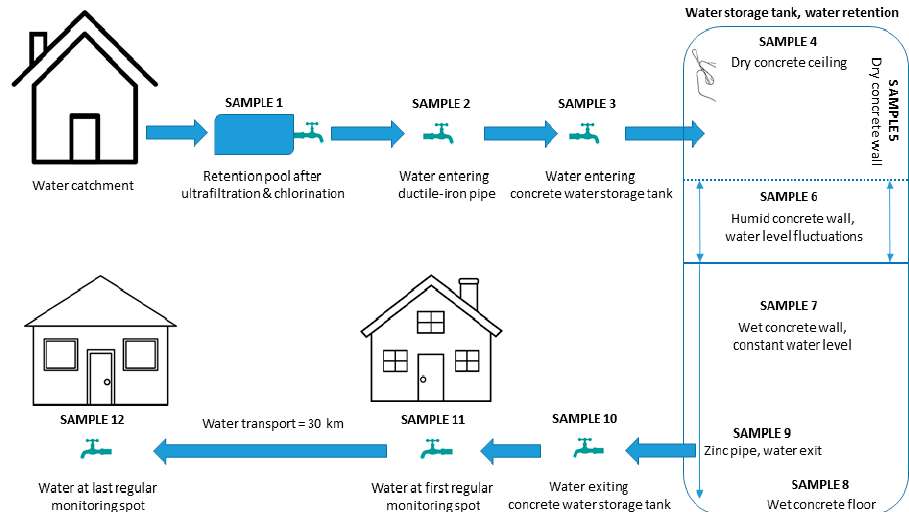
Figure 1. Sampling spots throughout water distribution system and inside concrete water storage tanks. Water samples are indicated as Sample-1, to -3, and Sample-10 to -12. Thick blue arrows indicate water flow. Samples inside the two concrete tanks that were taken by swabbing the surface are indicated as Sample-4 to -9. Thin blue arrows indicate water level as fluctuating or permanent.